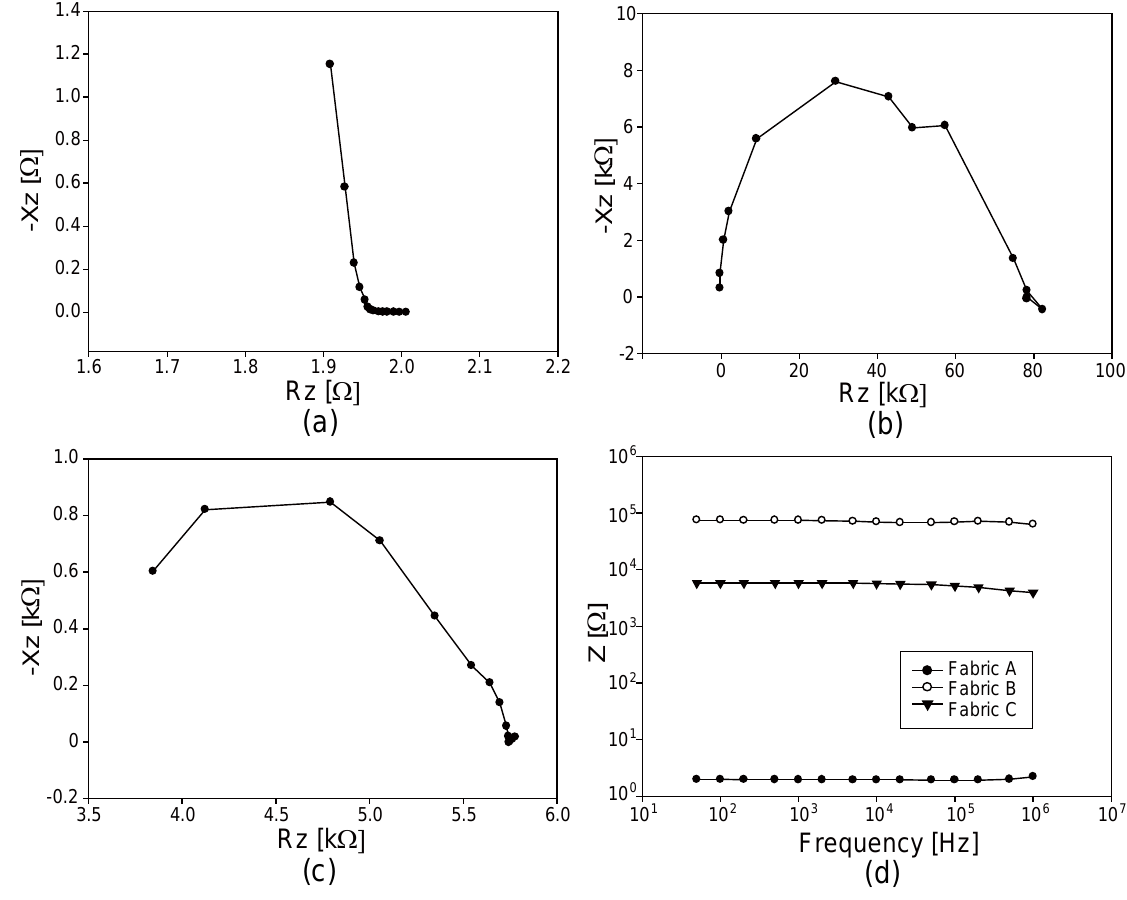
Figure 7. Argand diagrams of the impedance spectra from three conductive fabrics without any applied loading. ( a ), ( b ), and ( c ) are from the fabrics A, B, and C. ( d ) shows the plots of the impedance magnitude changes at 10